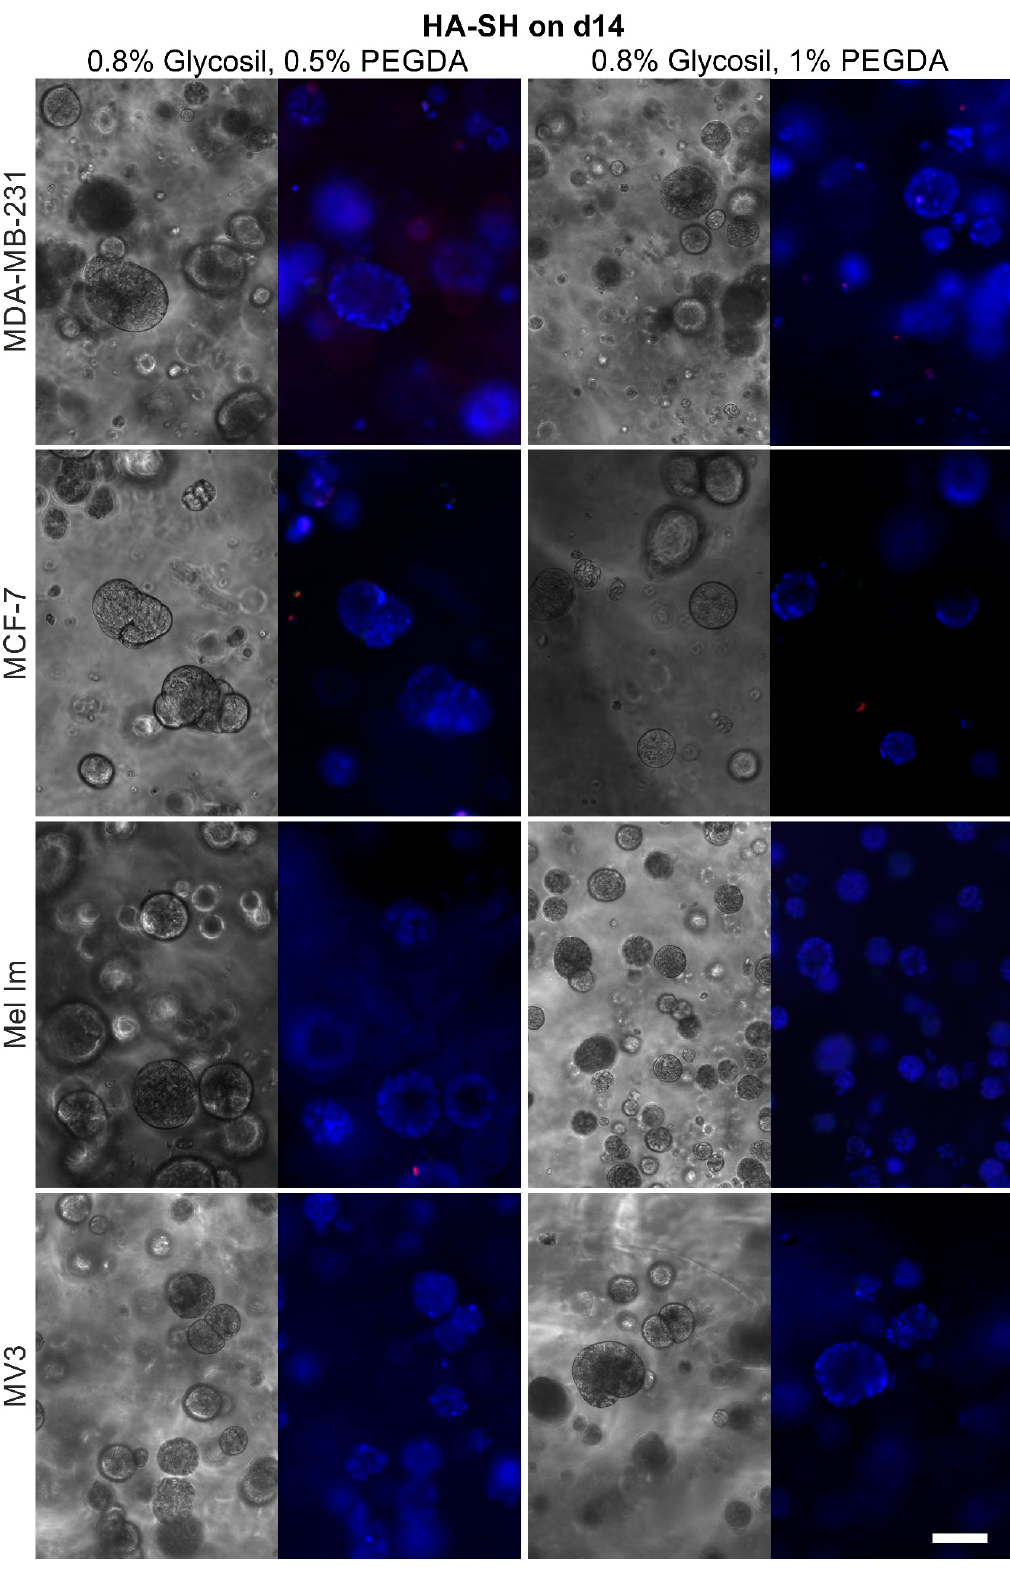
Figure 6. Representative phase contrast and fluorescence pictures of the cell survival and colony formation in HA-SH on day 14; adjacent pictures show the same position; blue = nucleic acid stain, green = apoptosis, and red = necrosis; scale bar = 100 µm.